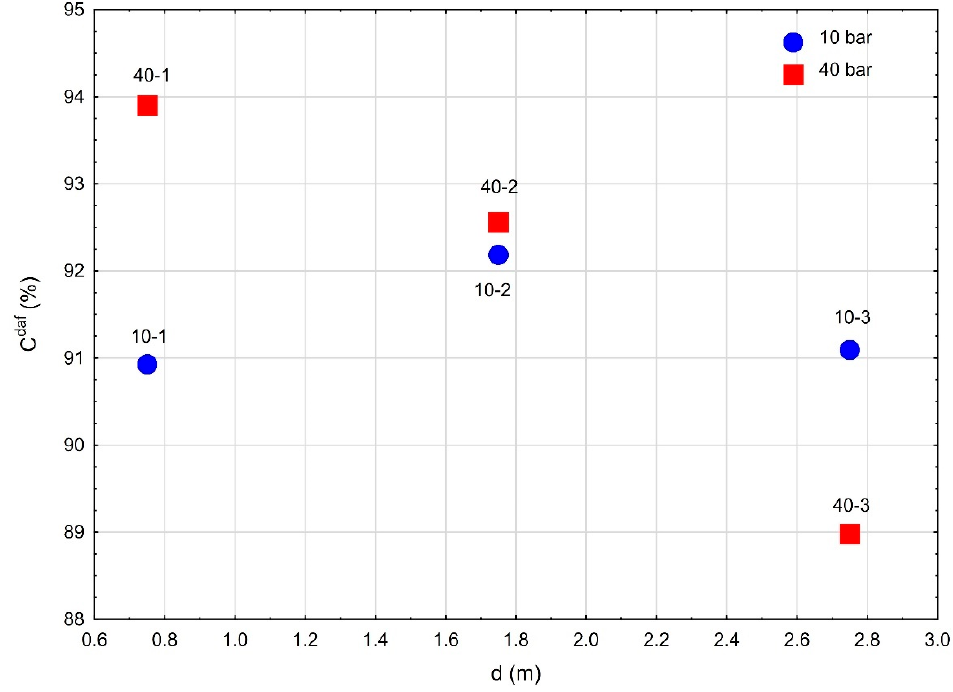
Figure 7. Relationship between C daf content and distance from the reactor chamber inlet.